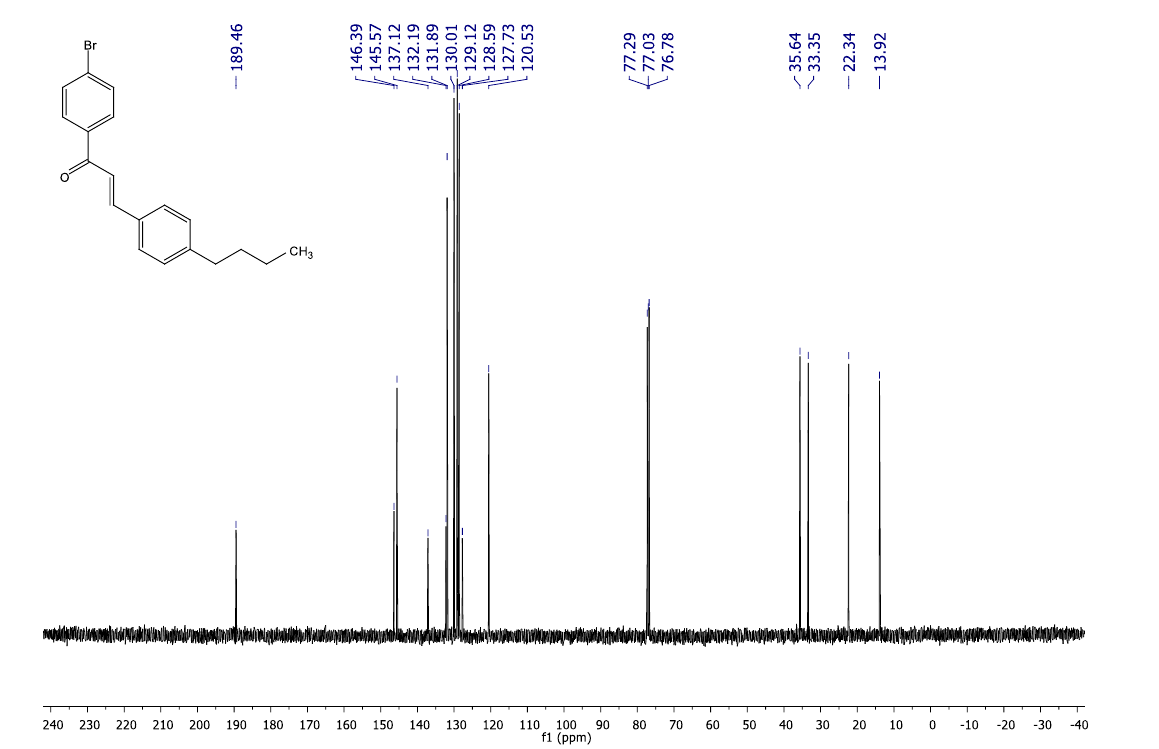
Figure 5. 13 C-NMR spectrum of BBP.